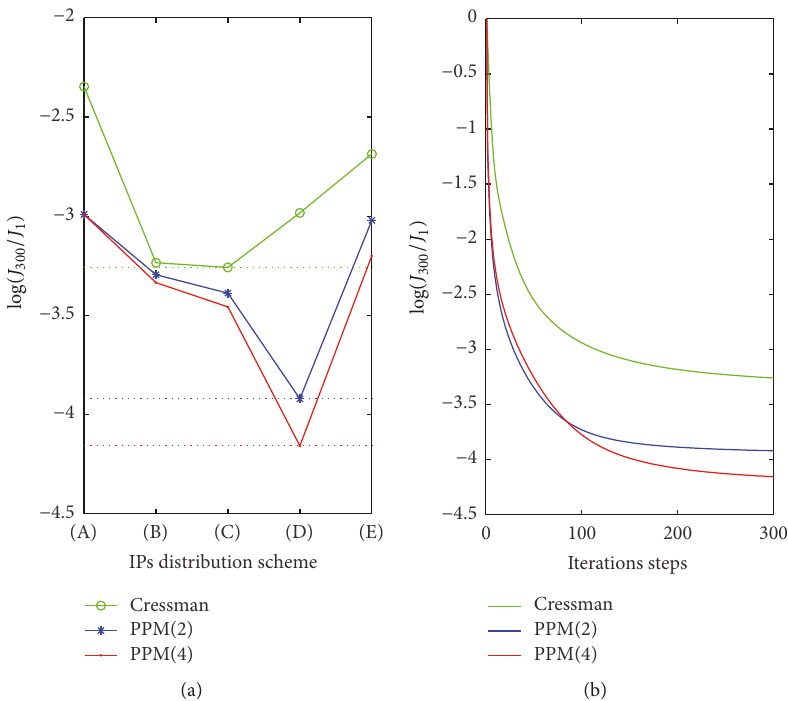
Figure 3: (a) The values of normalized cost functions versus IPs distribution schemes as after the assimilation. (b) The iteration histories of the cost function for three version IPS matched the optimal IPs distribution schemes. The abscissa indicates distribution scheme category of IPs. The solid lines are values of the given interpolations and the dotted lines indicate the minimum values of the solid lines,